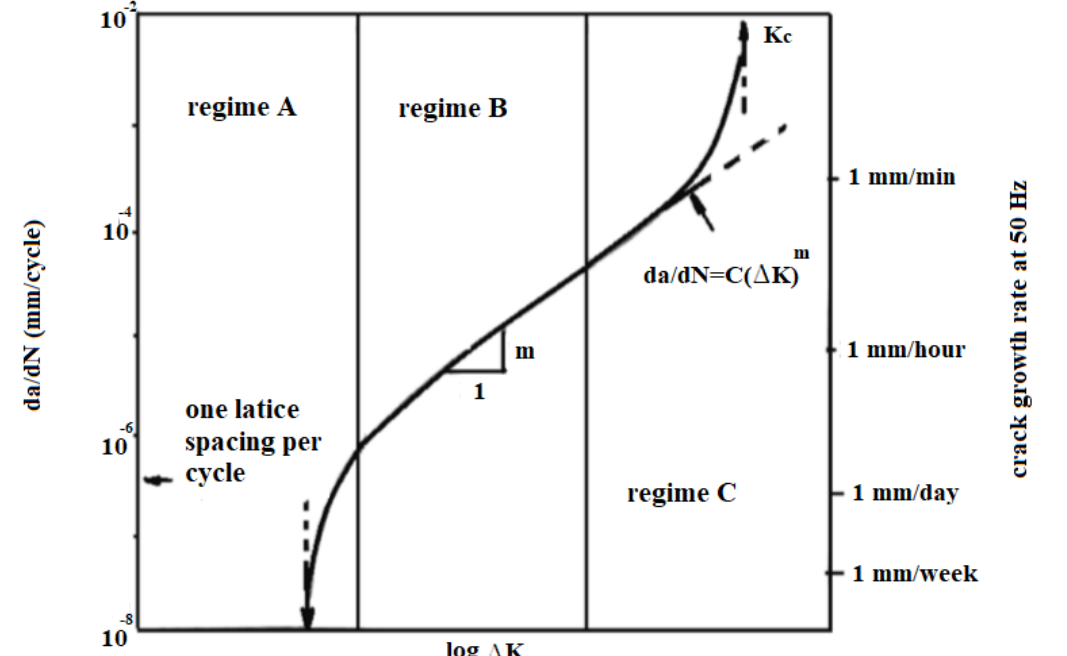
Figure 1. Different regimes of stable fatigue crack propagation [3]